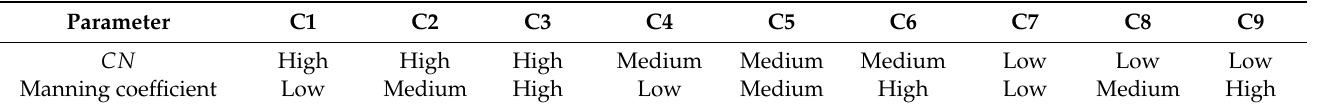
Table 4. Scenarios of CN and Manning coefficient combination.